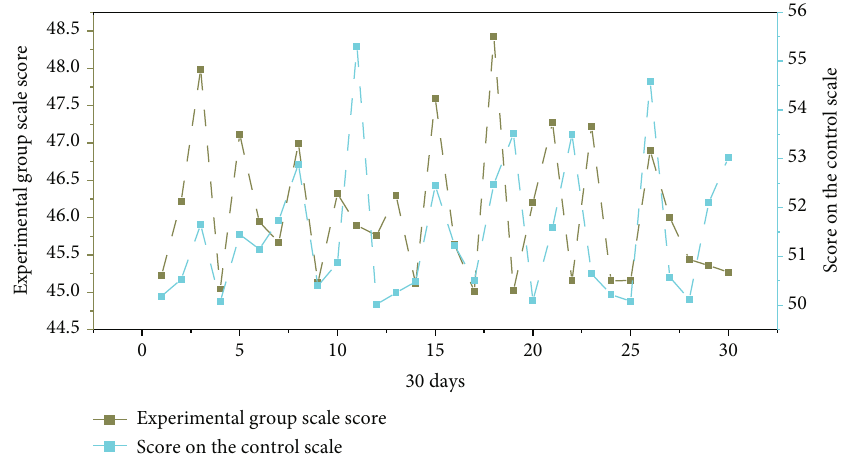
Figure 5: Comparison of scale scores between the experimental group and the control group.